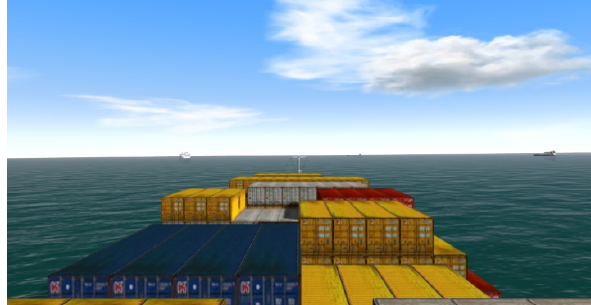
Fig. 7. Screenshot of the vessel, targets and weather conditions from the visualization channels of the simulator.